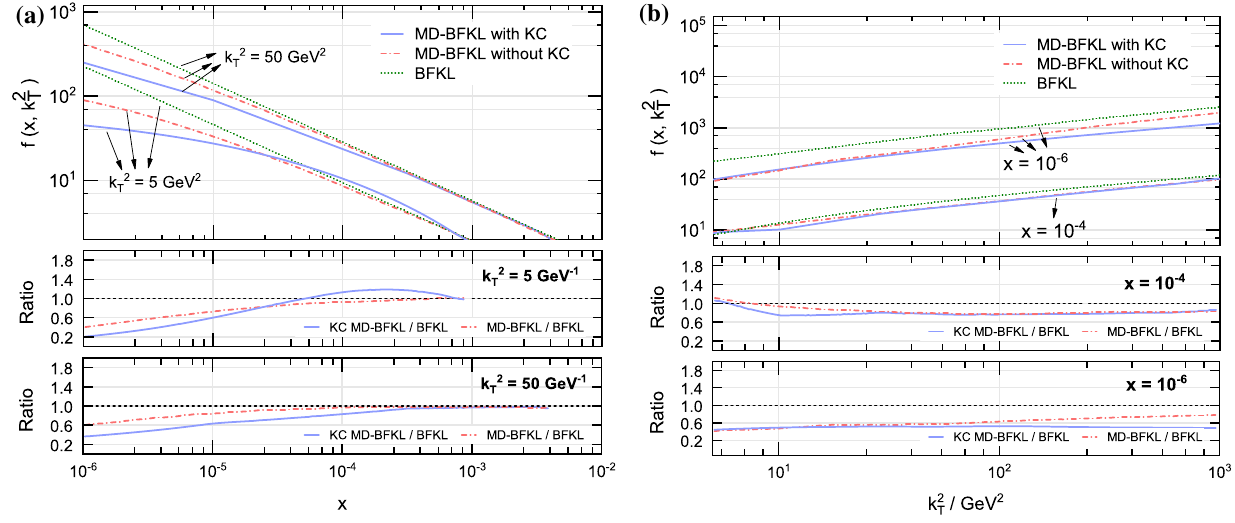
Fig. 8 a Comparison between linear BFKL, MD-BFKL without KC and MD-BFKL with KC for k 2 Comparison between linear BFKL, MD-BFKL without KC and MD-BFKL with KC for x evolution at k 2 shown for R = 5 GeV −